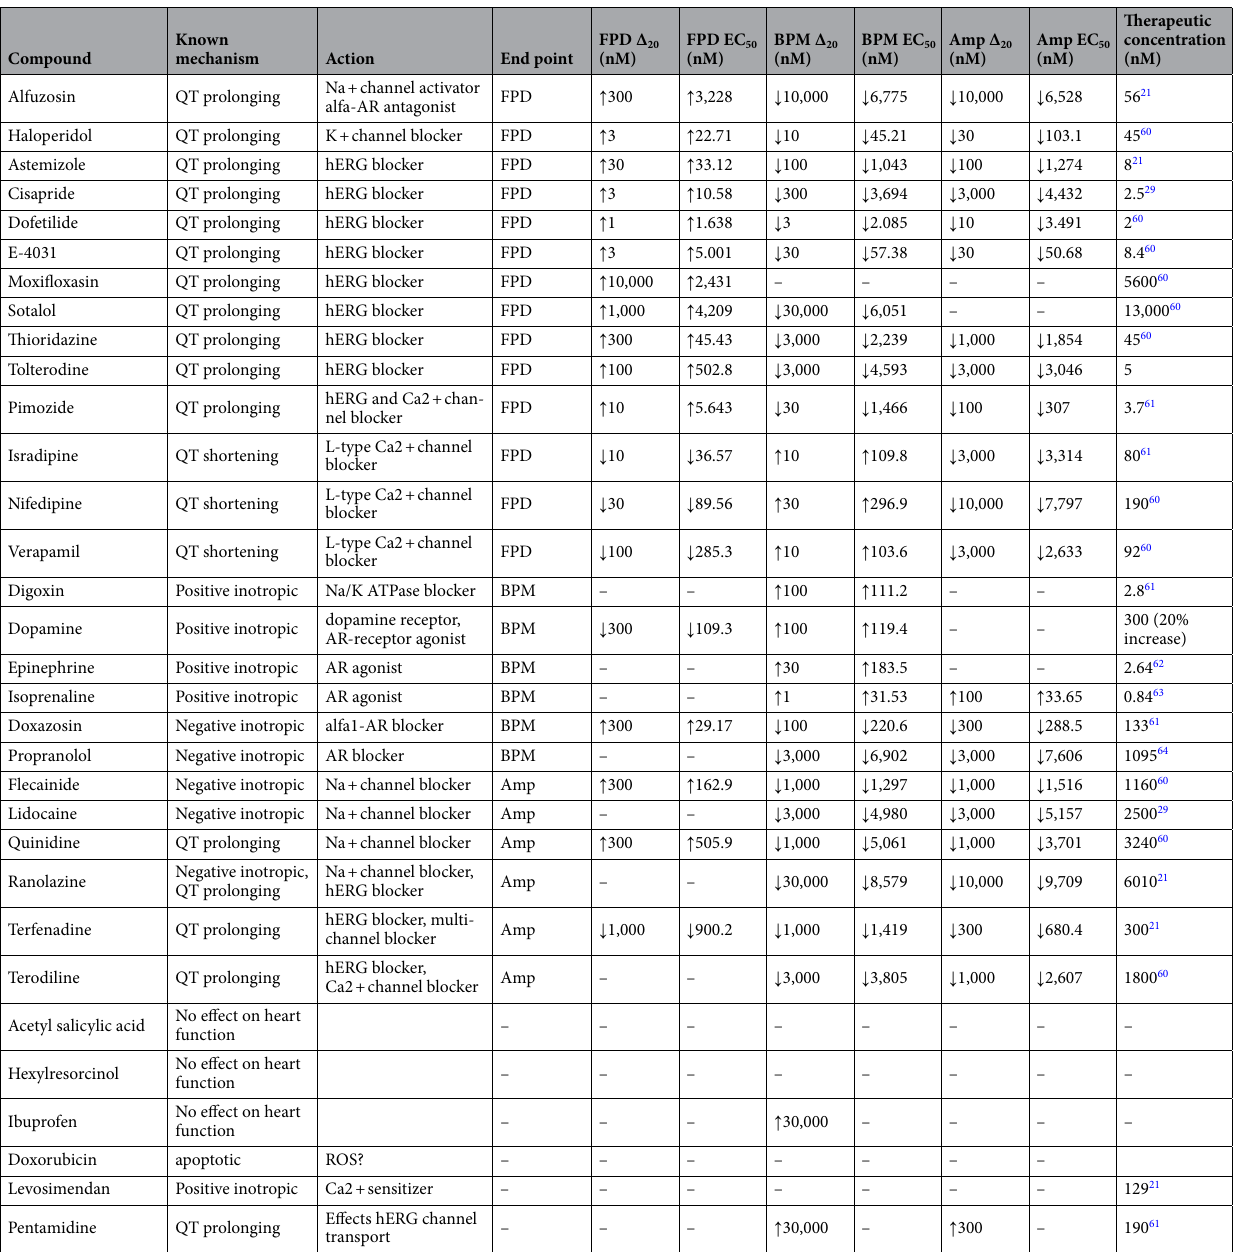
Table 1. Field potential duration (FPD), beats per minute (BPM), and Na + peak amplitude (Amp) Δ 20 and EC 50 values of all test compounds and therapeutic concentration of the compound. The symbol ↑ indicates an increase and the symbol ↓ indicates a decrease in the measured parameter. The reported concentrations from our model are the total (nominal) concentrations, and the therapeutic concentrations from the literature are the free plasma